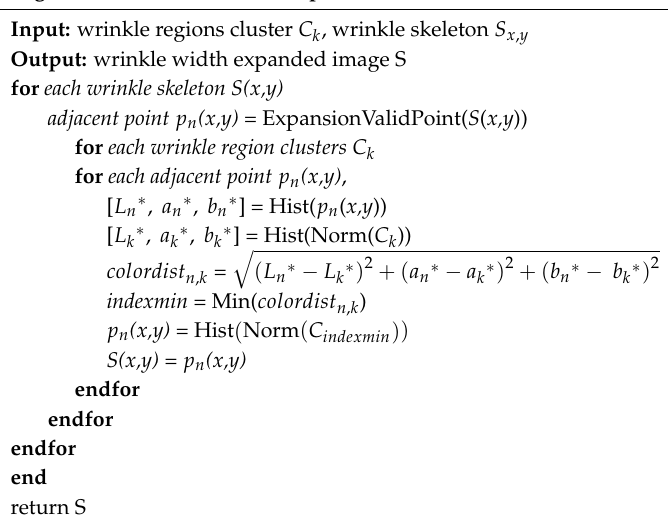
Algorithm 3. Wrinkle width expansion